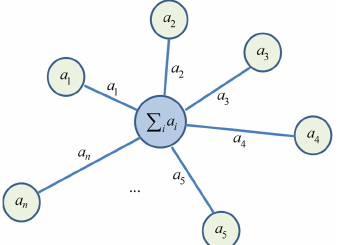
Figure 1. Weighted star graph representing the Hamiltonian block of this work.